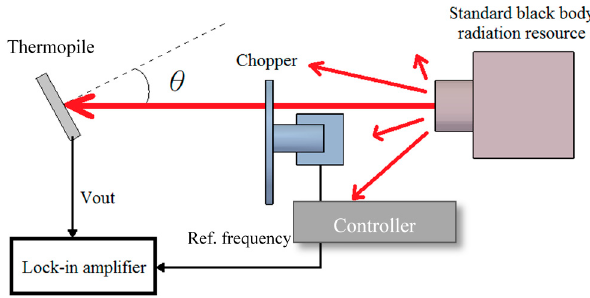
Figure 14. Measurement of IR incident angle for the thermopiles with and without rGO.